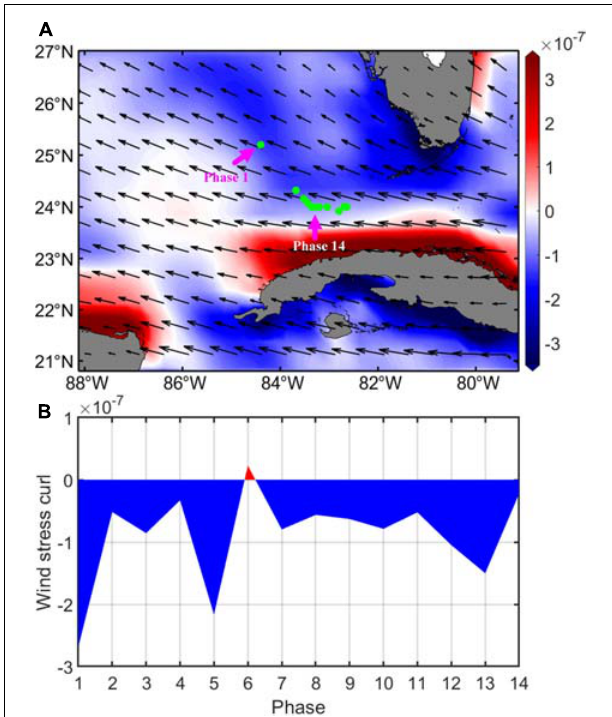
FIGURE 12 | (A) Distribution of mean wind stress curl (color shadings, unit: N/m 3 ) overlaid with the direction of mean wind stress (black vectors) during phases 1–18 (April 9 to August 12, 2017). Green dots represent the eddy centers determined from weekly global HYCOM surface current fields during phases 1–14 ( Figure 5 , April 9 to July 15, 2017), and they are the same as those shown in Figures 6B,10 . The eddy centers during phases 1 and 14 are annotated with magenta arrows. (B) Time series of the wind stress curl averaged horizontally over the effective eddy regions during phases 1–14 (April 9 to July 15, 2017). Blue color and red color denote negative and positive wind stress curl,